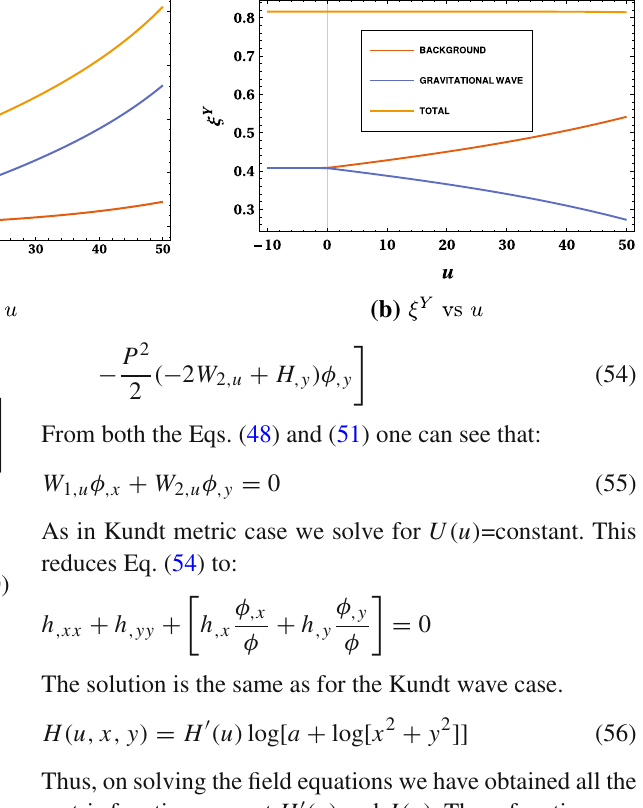
Fig. 4 Plot of deviation vectors along the coordinates X and Y for ω = +